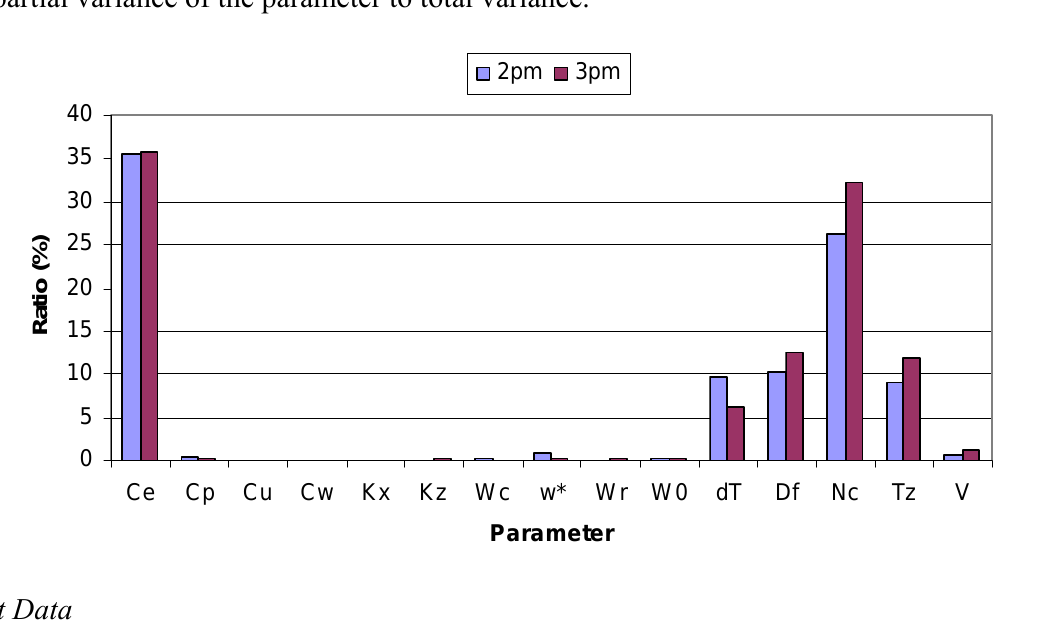
Figure 5. FAST sensitivity analysis of Daysmoke. The horizontal coordinate lists the model parameters (see Table 1 for their meanings). The vertical coordinate is the ratio (%) of partial variance of the parameter to total